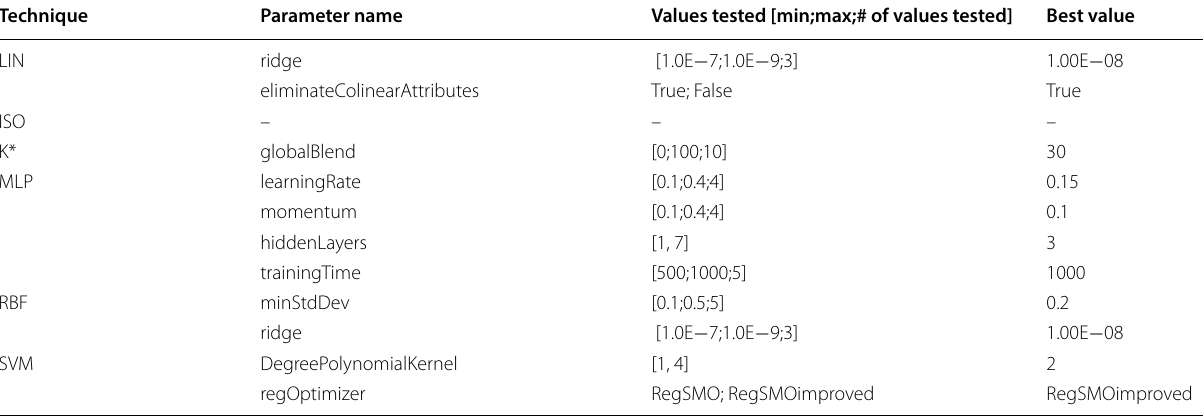
Table 4 Parameter tuning.